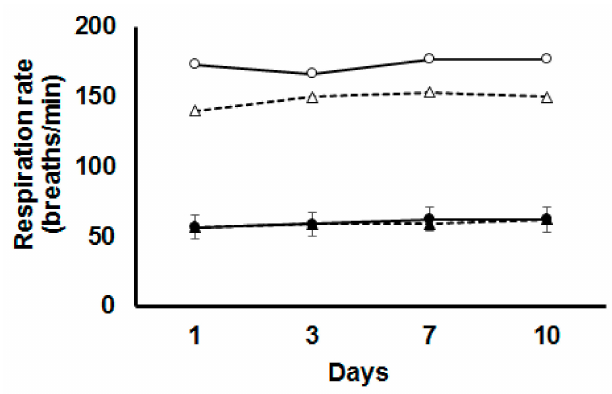
Figure 1. Respiration rate in broilers fed either a control diet (CON, round symbols) or betaine supplemented diet (BET, triangle symbols) after 1, 3, 7 and 10 days of being exposed to either thermoneutral (TN, filled symbols) or heat stress (HS, open symbols) conditions. The standard error of the di ff erence for Temperature × Diet × Day is displayed on the data for the chickens fed the CON diet under TN conditions.